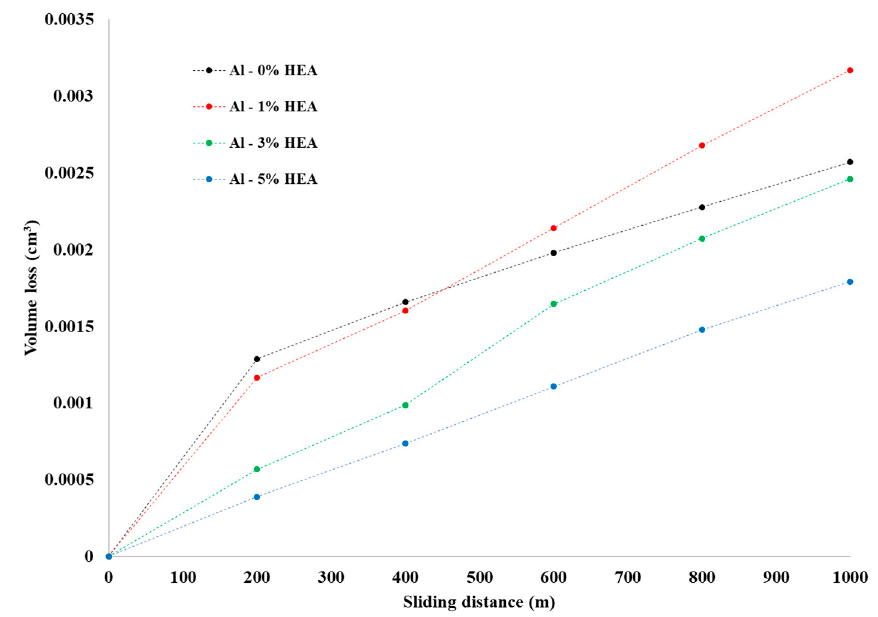
Figure 9. Volume loss versus sliding distance for each composition.